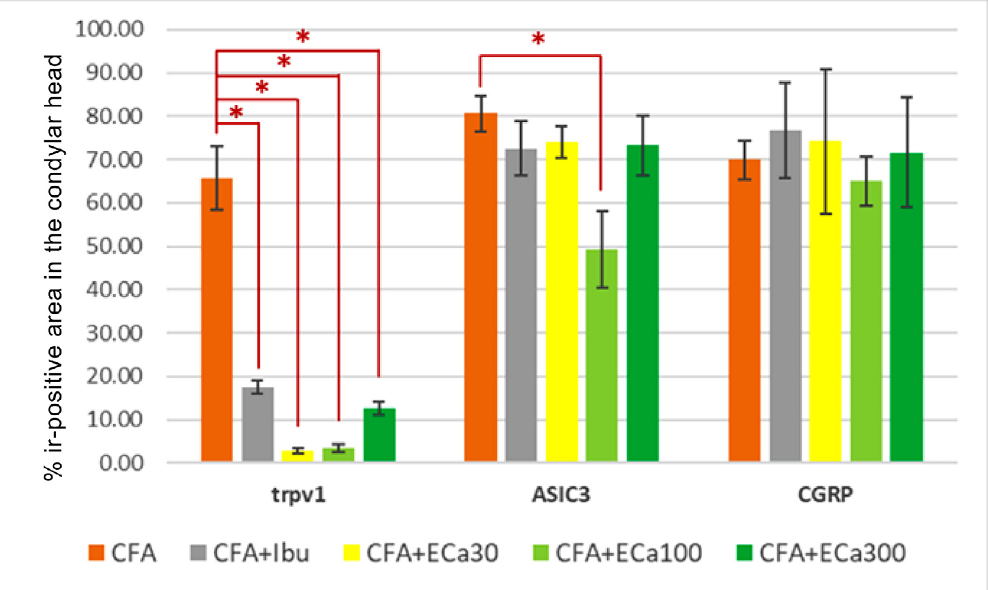
Figure 3- Graph showing the percentage of the ir-positive area in the condylar head of the ibuprofen and ECa 233-treated groups according to protein expression. One-way ANOVA with Dunnett’s test, n=5